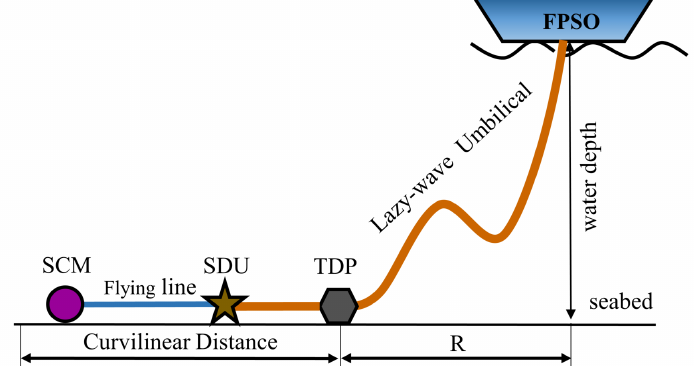
Figure 1. Simplified framework of subsea production control system.